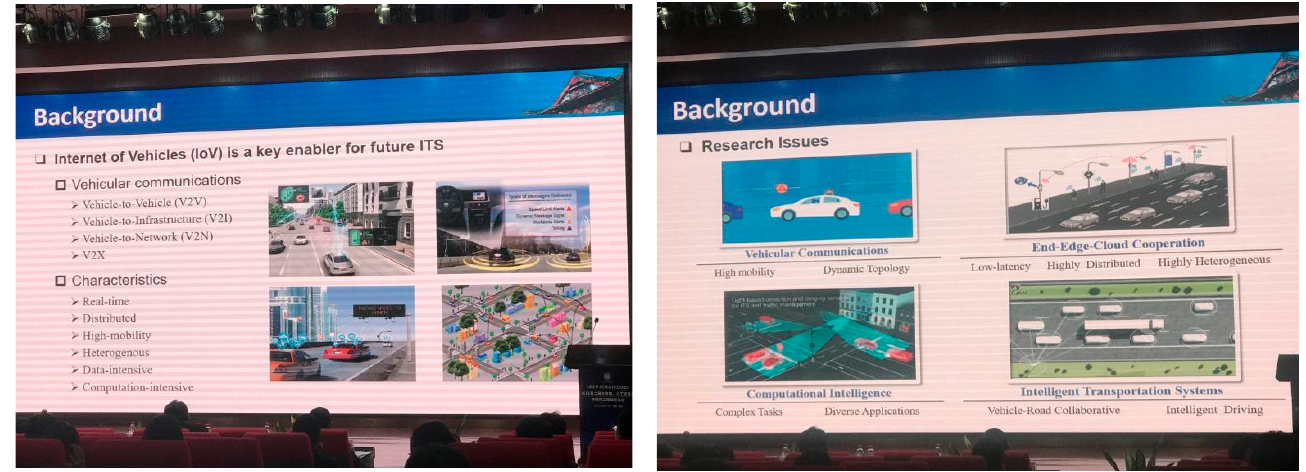
Figure 7. The speech of Professor Liu Kai: The Background of the Internet of Vehicles (IOV). In the third part, Professor Liu Kai revealed just a little bit of their focus of the research, that is, proposing a new heuristic algorithm for vehicle scheduling, as shown below Figure 8.